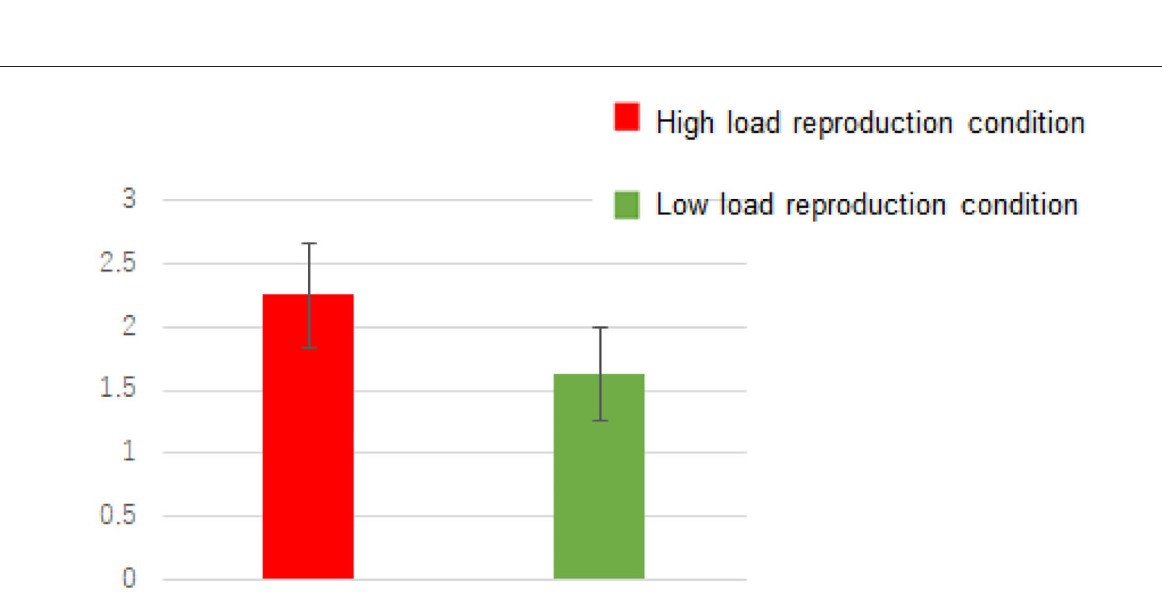
FIGURE8 Results of Experiment 2. The average value of the fatigue perception for each